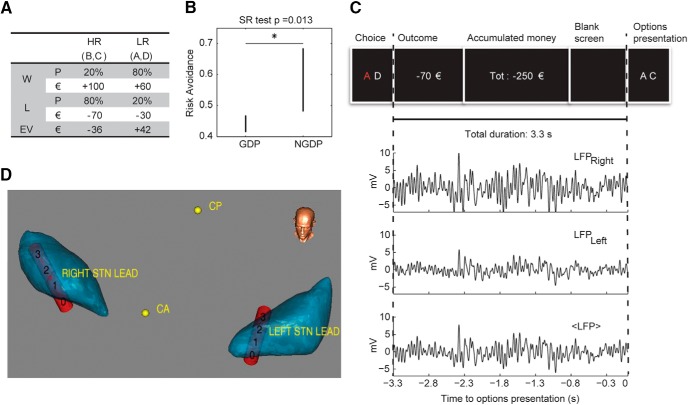
Economic task and STN LFP recordings. A, Letters, wins (W) and loss (L) probability (P) and value (€), and expected values (EV) associated with low-risk (LR) and high-risk (HR) options. B, Risk avoidance in GDPs (n = 6) and NGDPs (n = 6). Bars represent median confidence interval. Marker indicates significant difference (p = 0.013). C, Window of interest (3.3 s preceding options presentation). Top, sequence of visual stimuli in the window of interest. Bottom, processing of recorded LFP: raw data from right and left leads, and average LFP. D, 3D reconstruction of STN location of the STN (blue structures) and of the Medtronic 3389 DBS leads (red cylinders) with 0–3 contacts in one example GDP subject (#6). CA and CP indicate the anterior and posterior commissure.